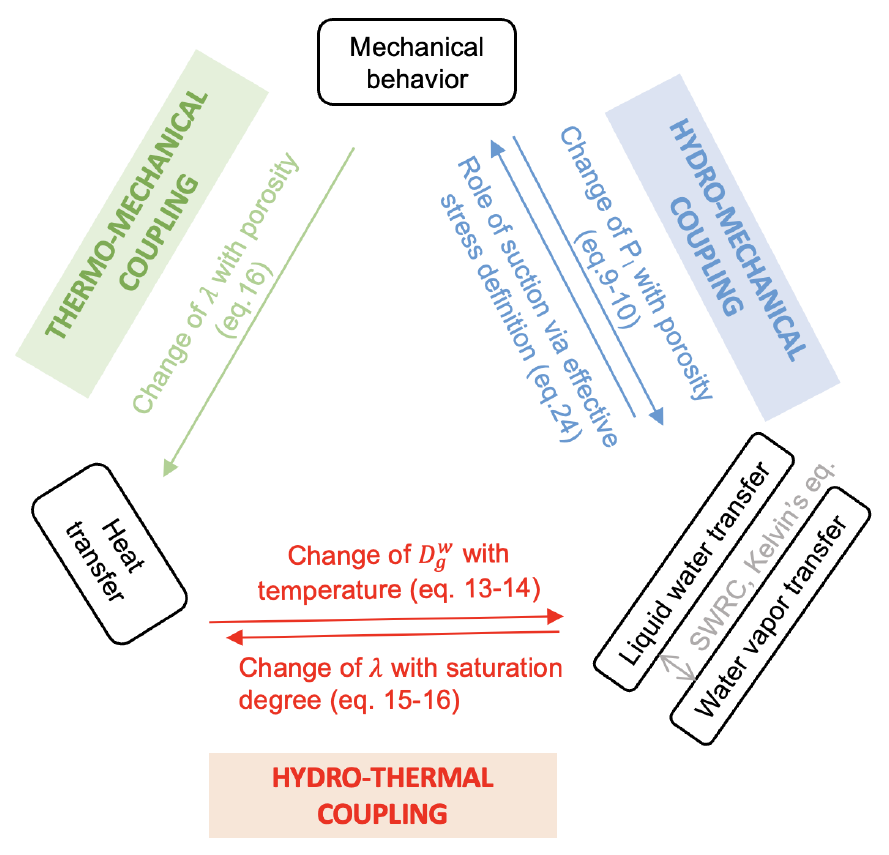
Figure 4. THM coupling between the mechanical behavior, liquid water and vapor transfer, and heat